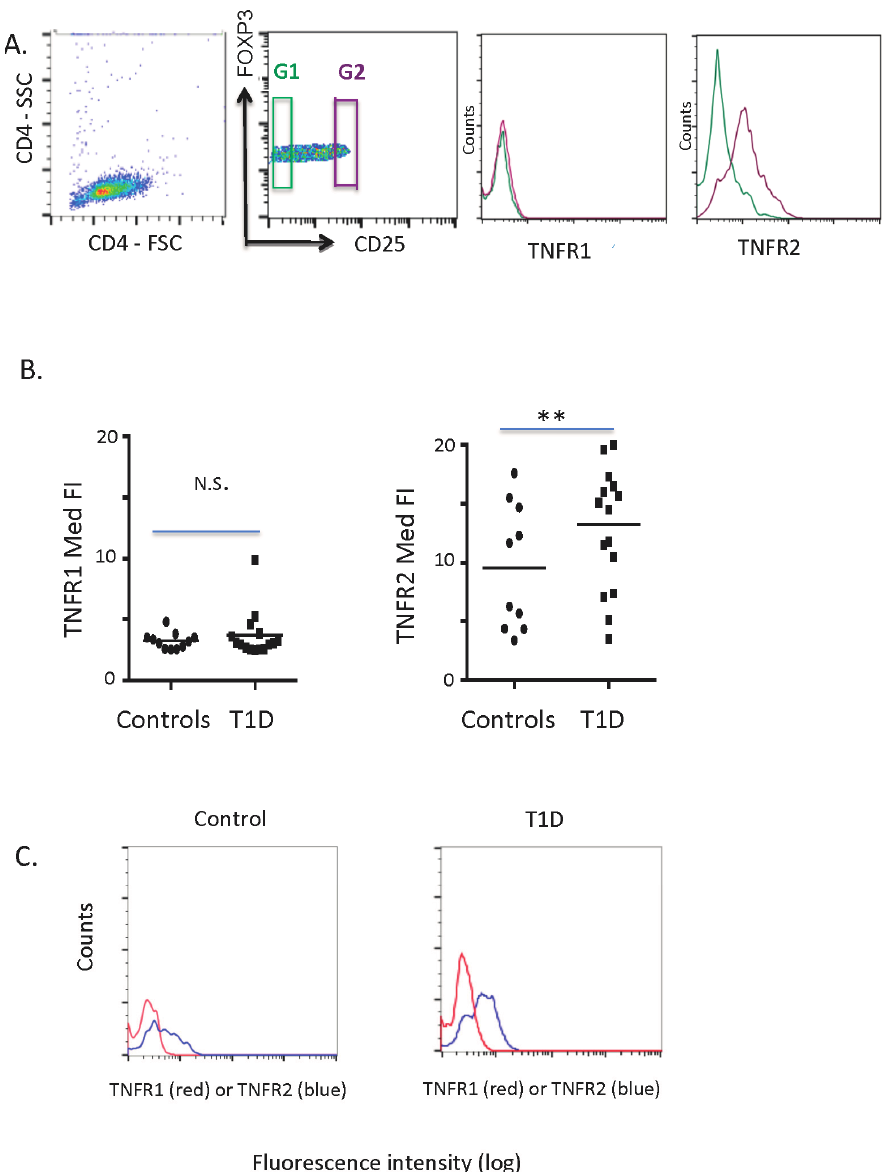
Figure 1. The study of freshly isolated human CD4 T cells for Treg identification and the expression of TNFR1 versus TNFR2 in a comparison of type 1 diabetic (T1D) versus control subjects. ( A ) Freshly isolated normal human CD4 T cells show that TNFR2 is preferentially and highly expressed on CD4CD25hi T cells (G2 versus G1 gate) in normal controls. In contrast, TNFR1 is expressed in low amounts on CD4CD25hi (G2 gate) or on CD4CD25low (G1 gate) T cells. ( B ) The median fluorescence intensity (Med FI) of TNFR1 and TNFR2 on freshly isolated CD4 T cells, a comparison of TNFR1 of type 1 diabetic (n = 15) to control (n = 11) subjects, p = 0.95, left. A comparison of TNFR2 of type 1 diabetic (n = 18) to control (n = 10) subjects, ** p = 0.02, right. ( C ) TNFR1 staining curves (red) compared to TNFR2 curves (blue) of freshly isolated control Tregs (left, n = 1) compared to freshly isolated type 1 diabetic Tregs (right, n = 1). These are representative